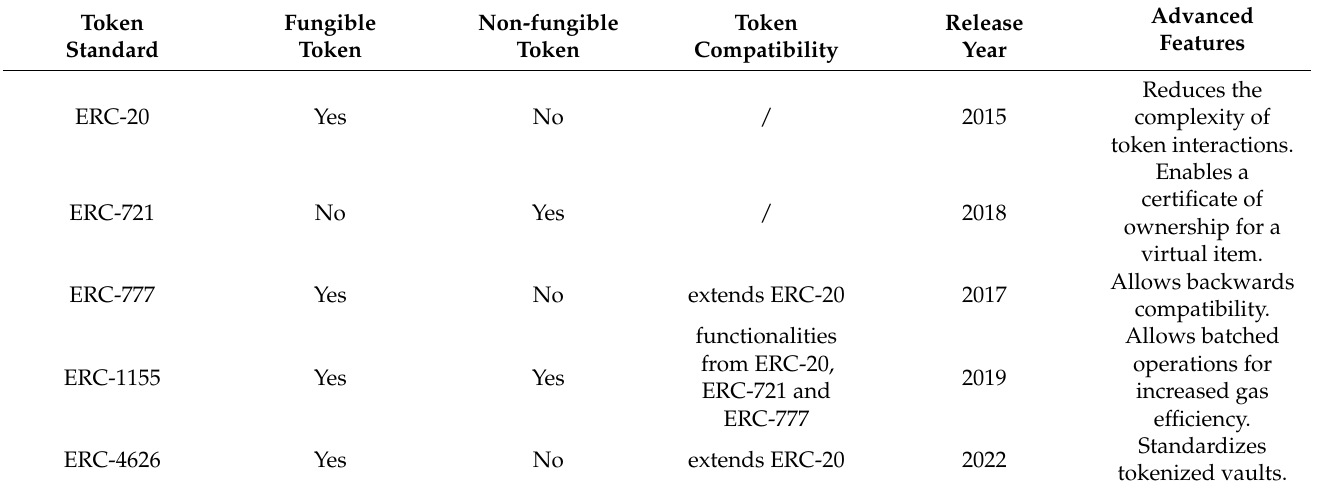
Table 1. Comparison among the available EVM-compliant token